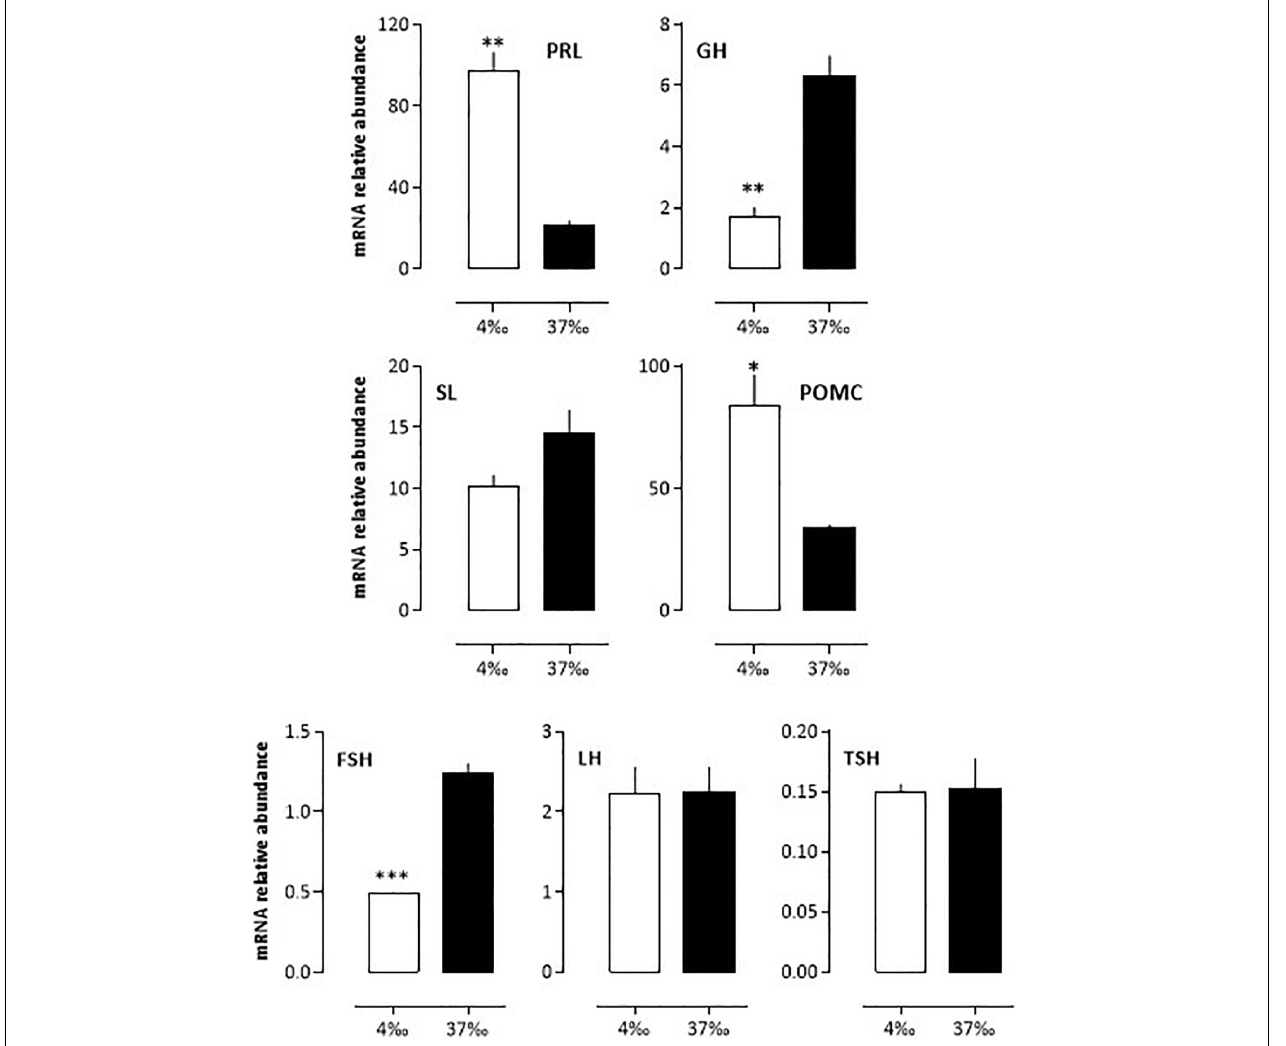
salinities. BW fish were maintained (cid:104)